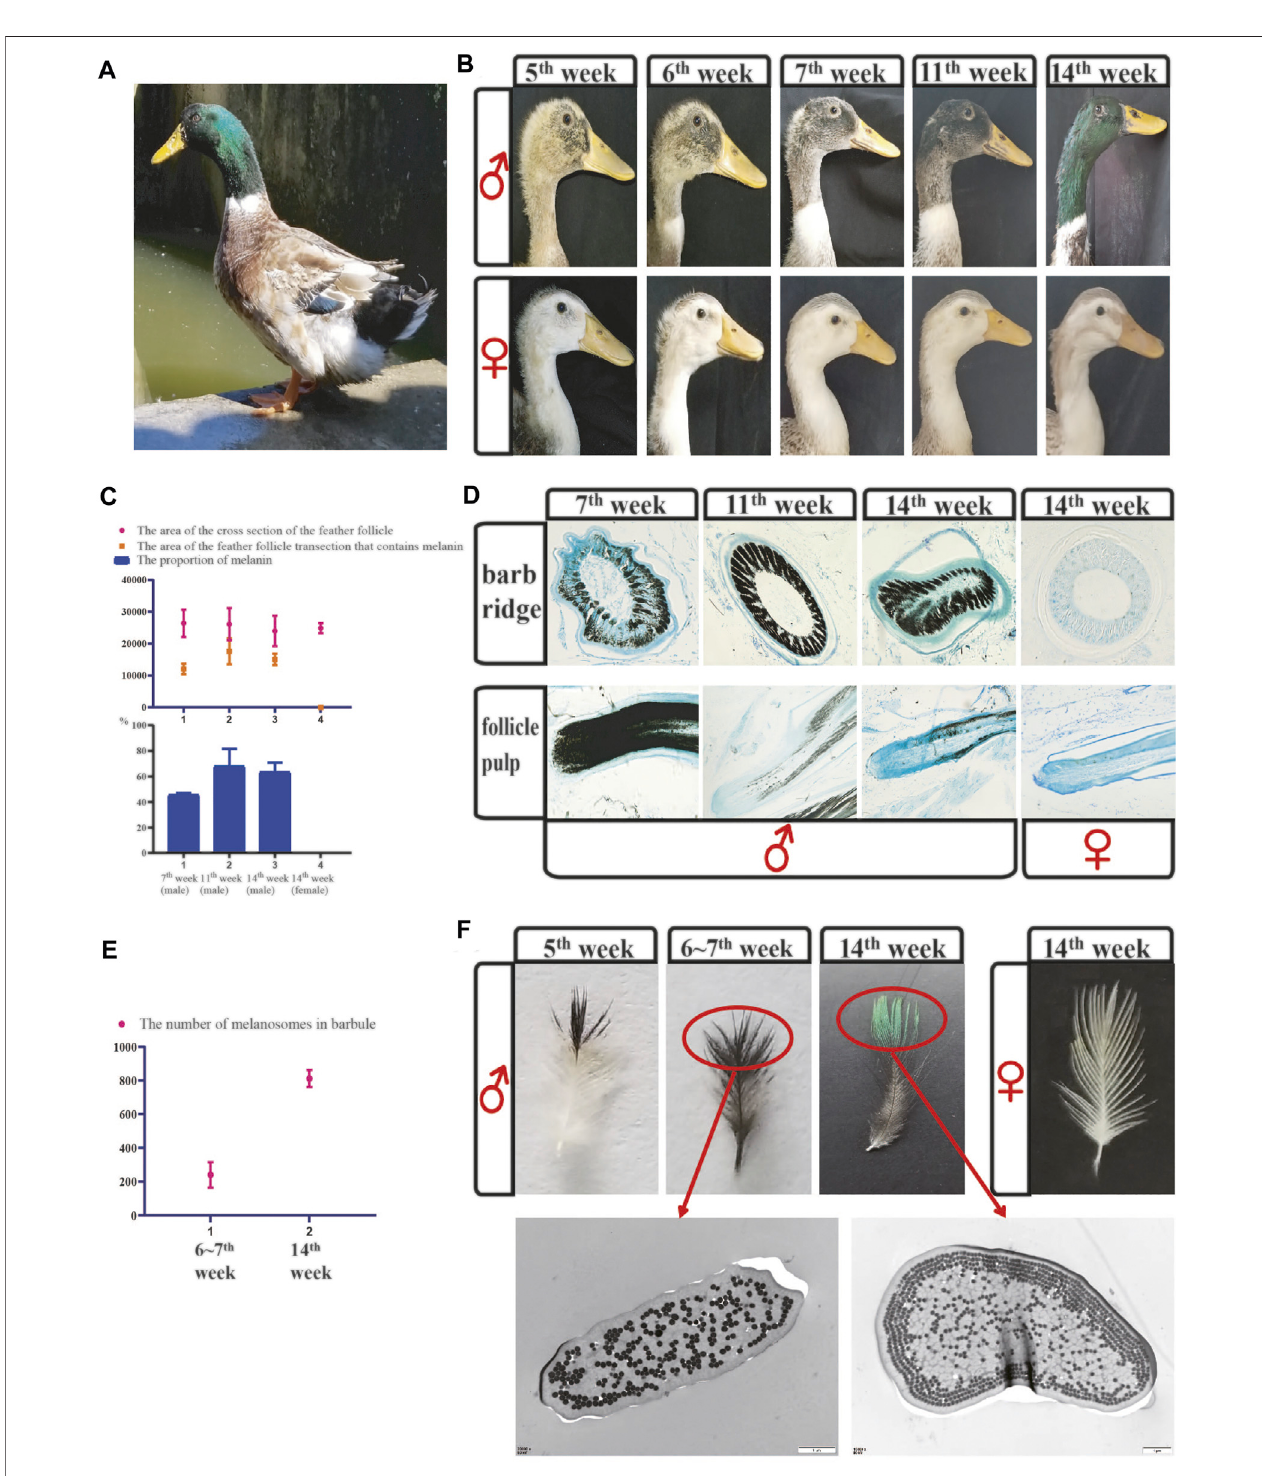
FIGURE 1 | The difference in feather color between males and females revealed microscopic and anatomical observations. (A) Image of a male mallard. (B) Color changesofthehead feathers inmallardsatdifferentgrowthstages. (C) Themelanincontentinthebarbridges ofmallardswasmeasured usingIPPsoftware. (D) Cross- sections of the barb ridges and vertical sections of the feather follicle pulp in mallards at different growth stages. (E) The number of melanosomes was calculated using IPP software in thebarbules ofmallards. (F) In Figure 1F ,the featherswere isolated from the head of male and female mallards at different growth stages. And the Figure 1F shows TEM sections of individual small barbules from the distal region indicated TEM (transmission electron microscope) images of vertical sections of the small barbules; scale bar (cid:1) 1 μ m.